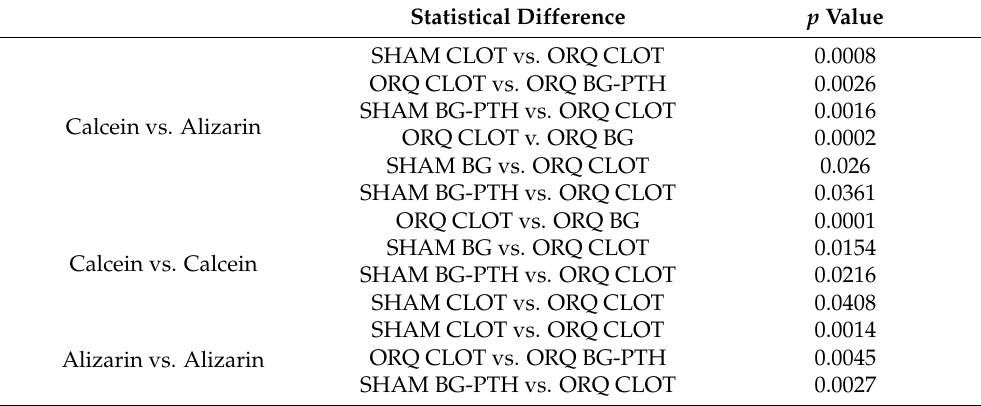
Table 3. Representation of bone dynamics: calcein vs. alizarin; calcein vs. calcein and alizarin vs. alizarin to represent the statistical difference between all groups SHAM vs. ORQ (CLOT, BG and BG-PTH), indicate significance at p < 0.05.